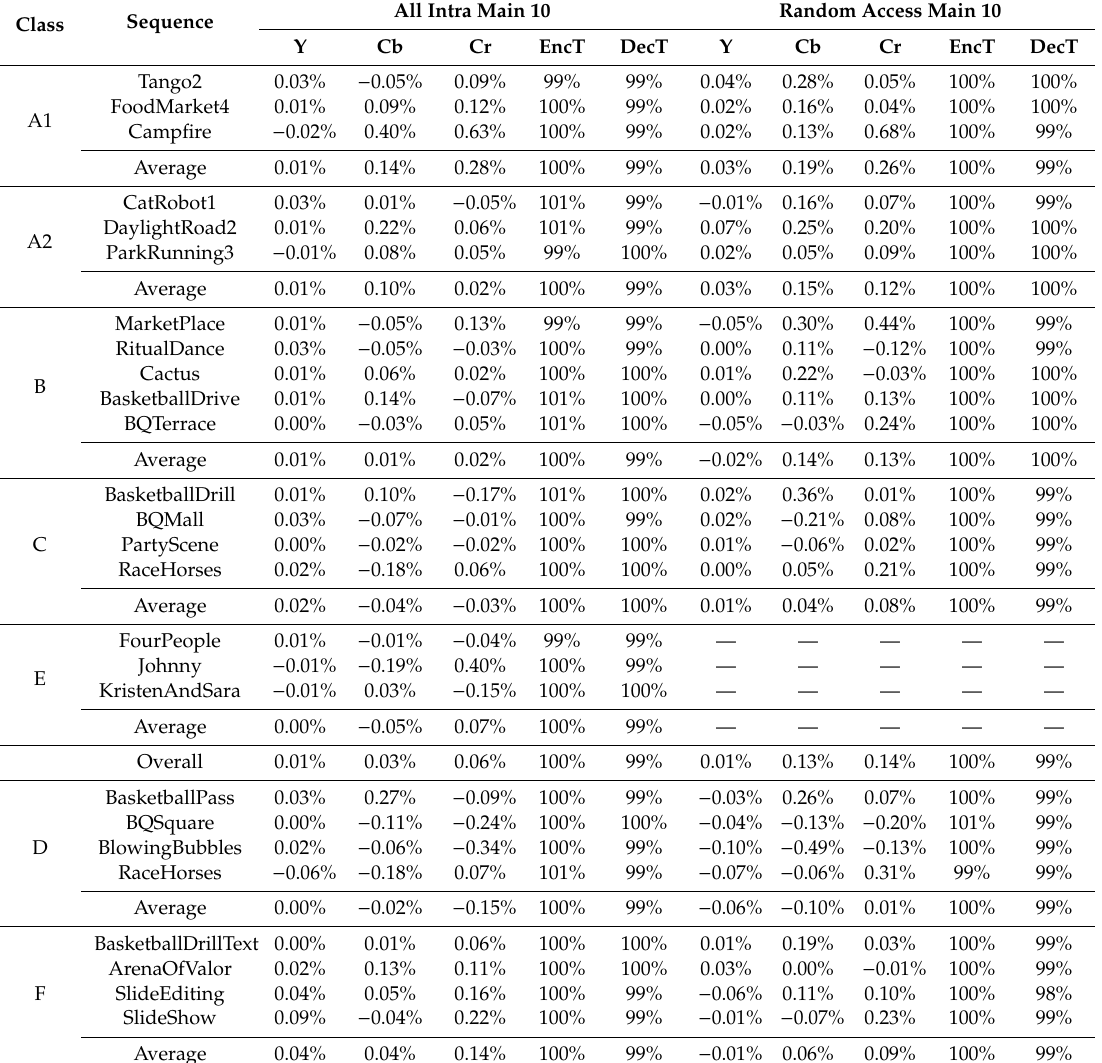
Table 6. Experimental results of the proposed CCLM compared to